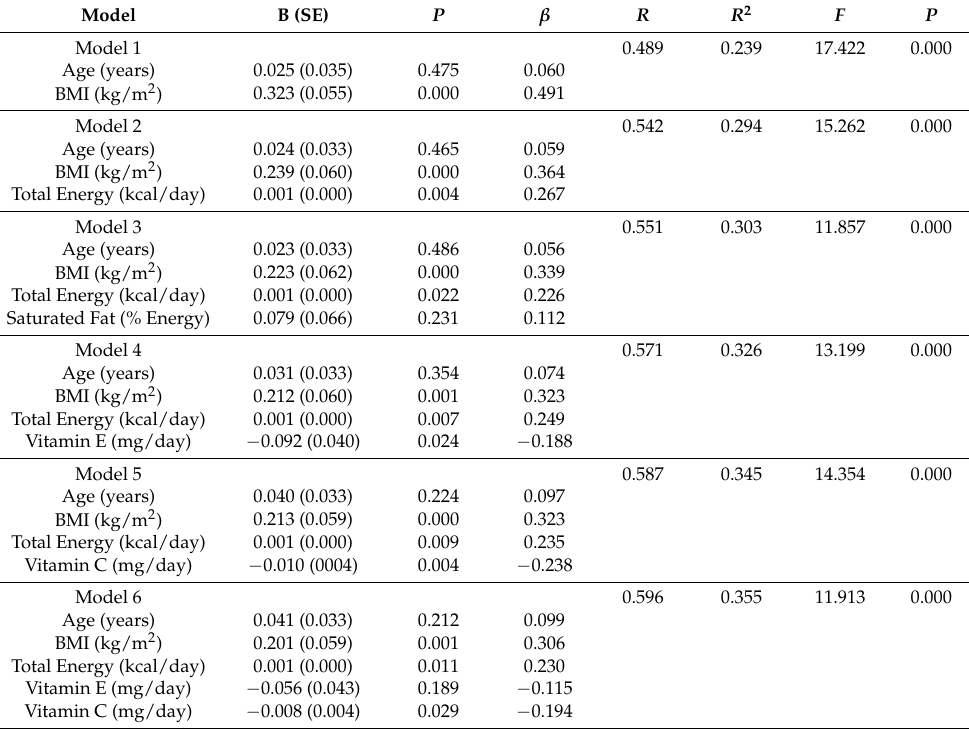
Table 4. Impact of BMI, total energy (kcal/day), SFA intake (% Energy), and vitamins C and E (mg/day) on DNA damage assessed by hierarchical linear regression